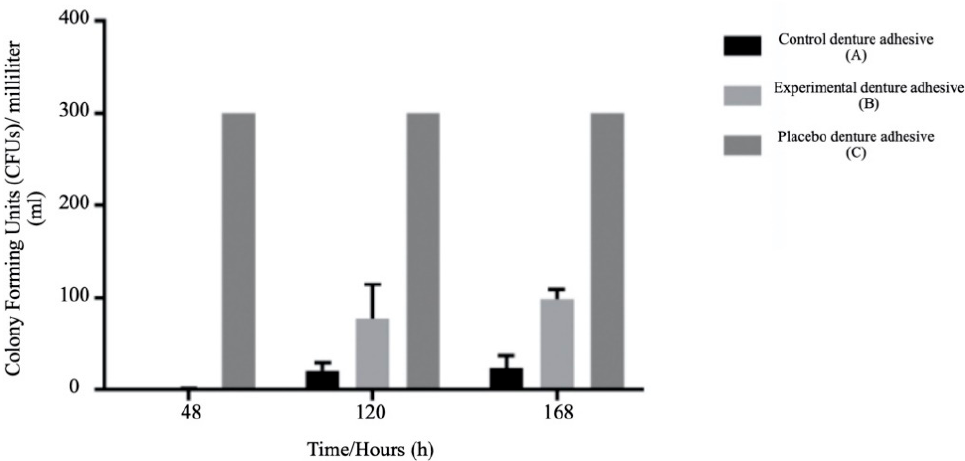
Figure 2. Effect of the denture adhesives on the growth of Candida albicans ATCC 11225 in the Sabouraud dextrose agar (SDA) medium.